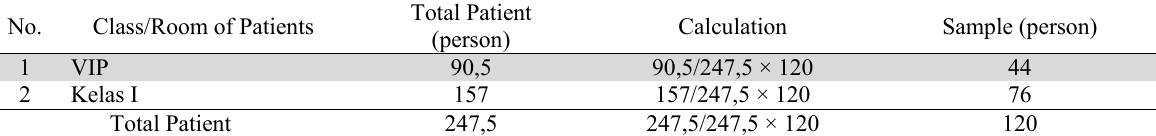
Source: Bahteramas General Hospital in